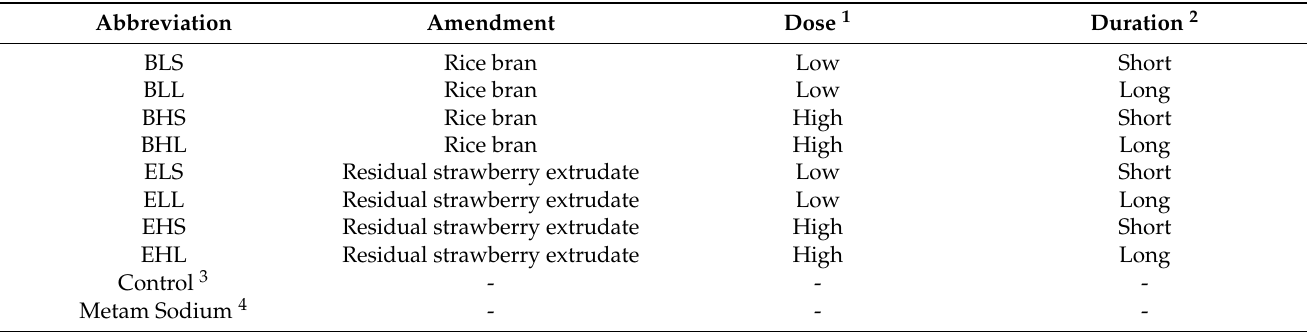
Table 3. Treatments in the anaerobic soil disinfestation (ASD)